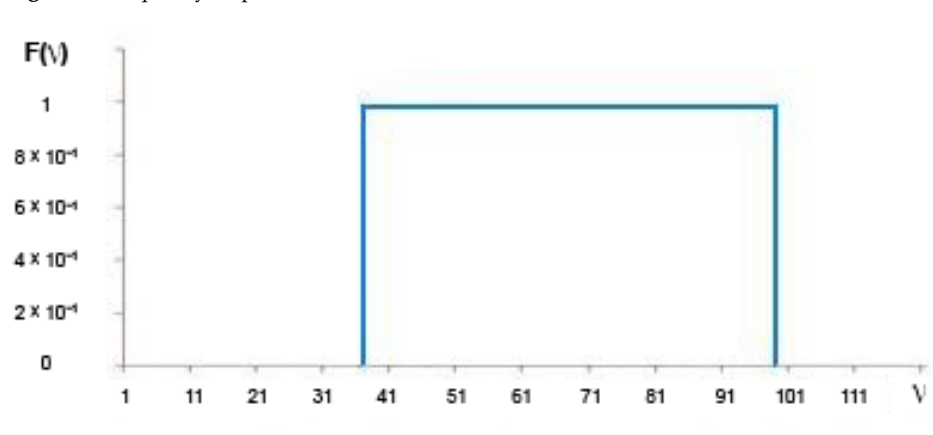
Figure 7. Frequency response.